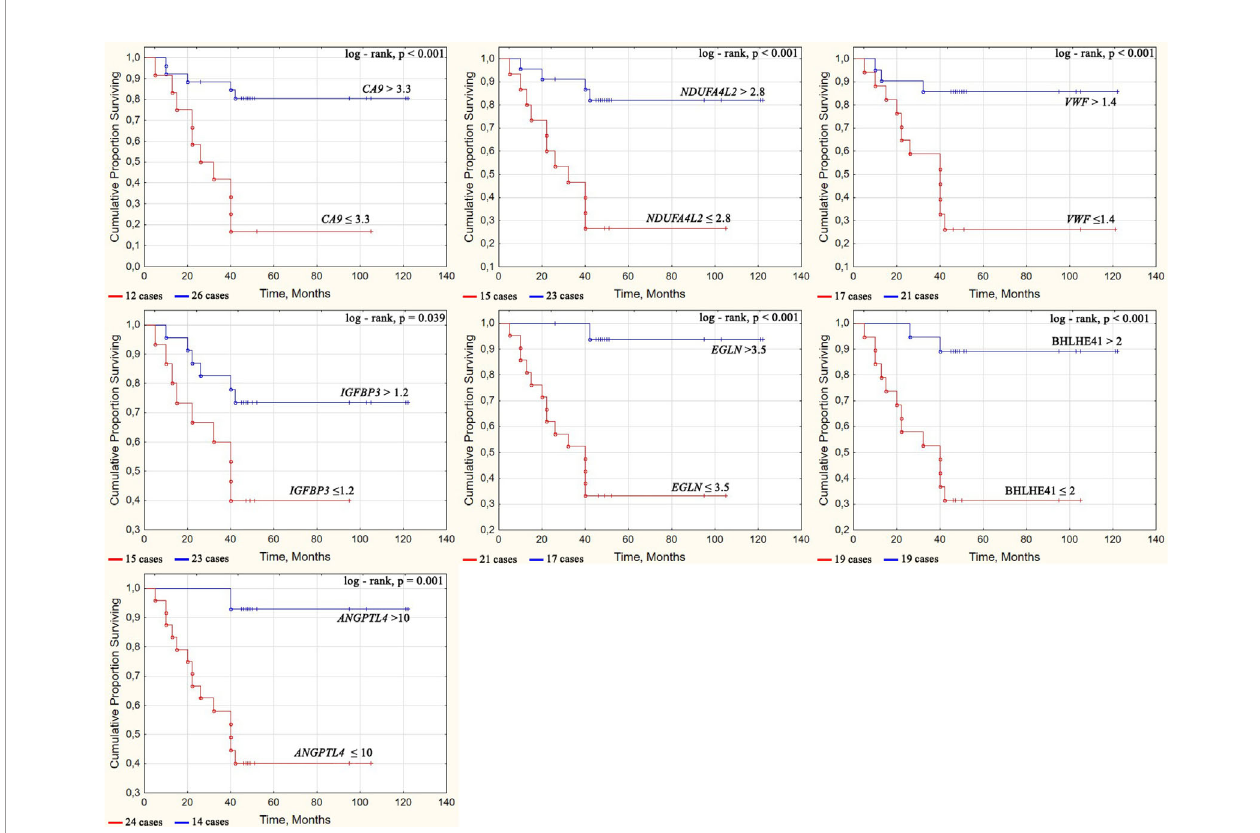
FIGURE 4 | Survival curves of ccRCC patients depending on the gene expression level. Some cases have values that are close in time, so they may not be easily distinguishable on the graph. The number of cases for each Kaplan – Mayer curve is given under the